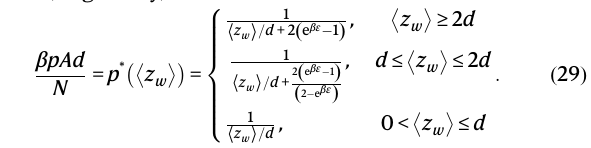
Fig. 2. On each branch, we fi nd thermodynamically stable states (black parts) but alsosome metastable states (orange parts with higher Gibbs free energy than the stable states). So, the Gibbs free energy is not a single-valued function and in some region, it can have even three values for a given pressure (see the region between p c 1 and p c 2 in Fig. 2). The two crossing points, p c 1 and p c 2 are cusps, i.e., the fi rst derivative at these points is discontinuous, which gives, in conse- quence two discontinuous jumps of pore width. We will see this when discussing the compression-expansion isotherm.